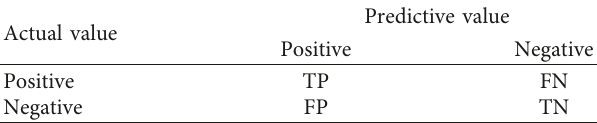
Table 3: Confusion matrix.